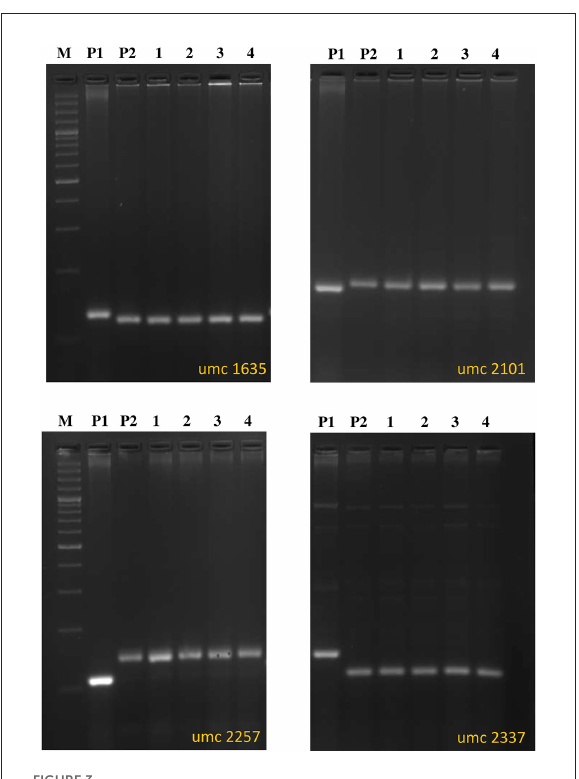
FIGURE3 Background selection using SSR markers for selected improved lines from BC 2 F 3 generation of SC11-2 × UMI 1230 β 1 + .